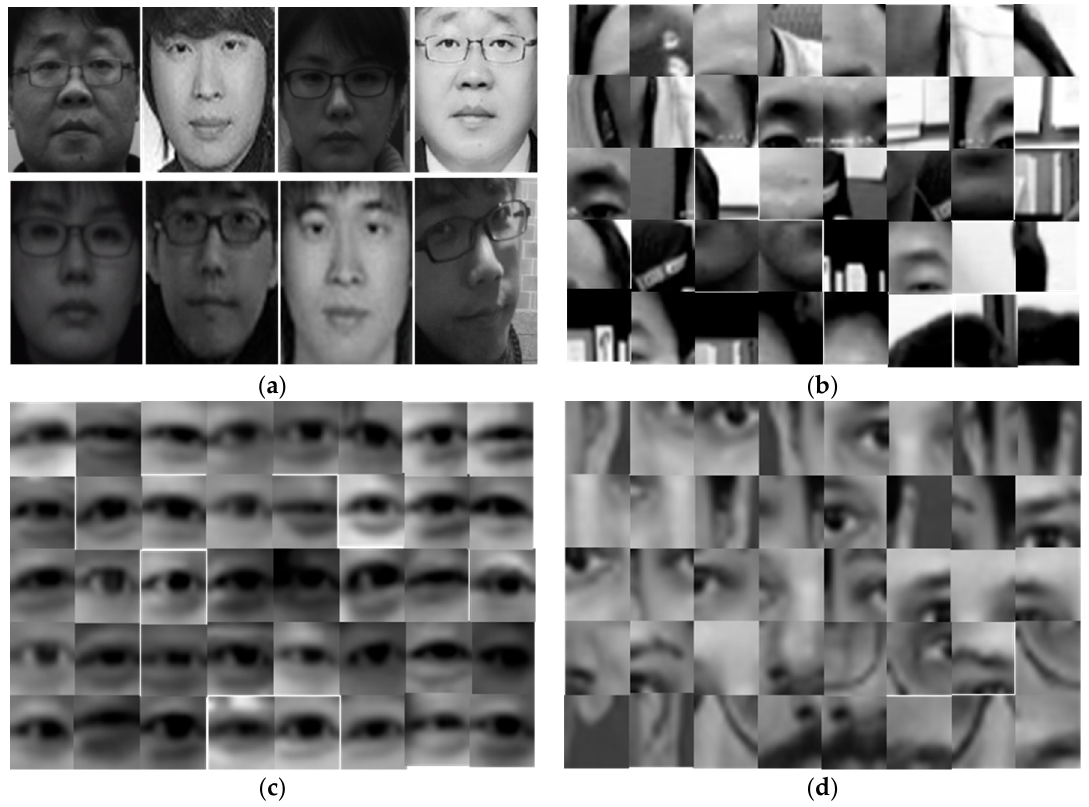
Figure 3. Examples of a training dataset for face and eye detection: ( a ) positive training set for face detection, ( b ) negative training set for face detection, ( c ) positive training set for eye detection, and ( d ) negative training set for eye detection.